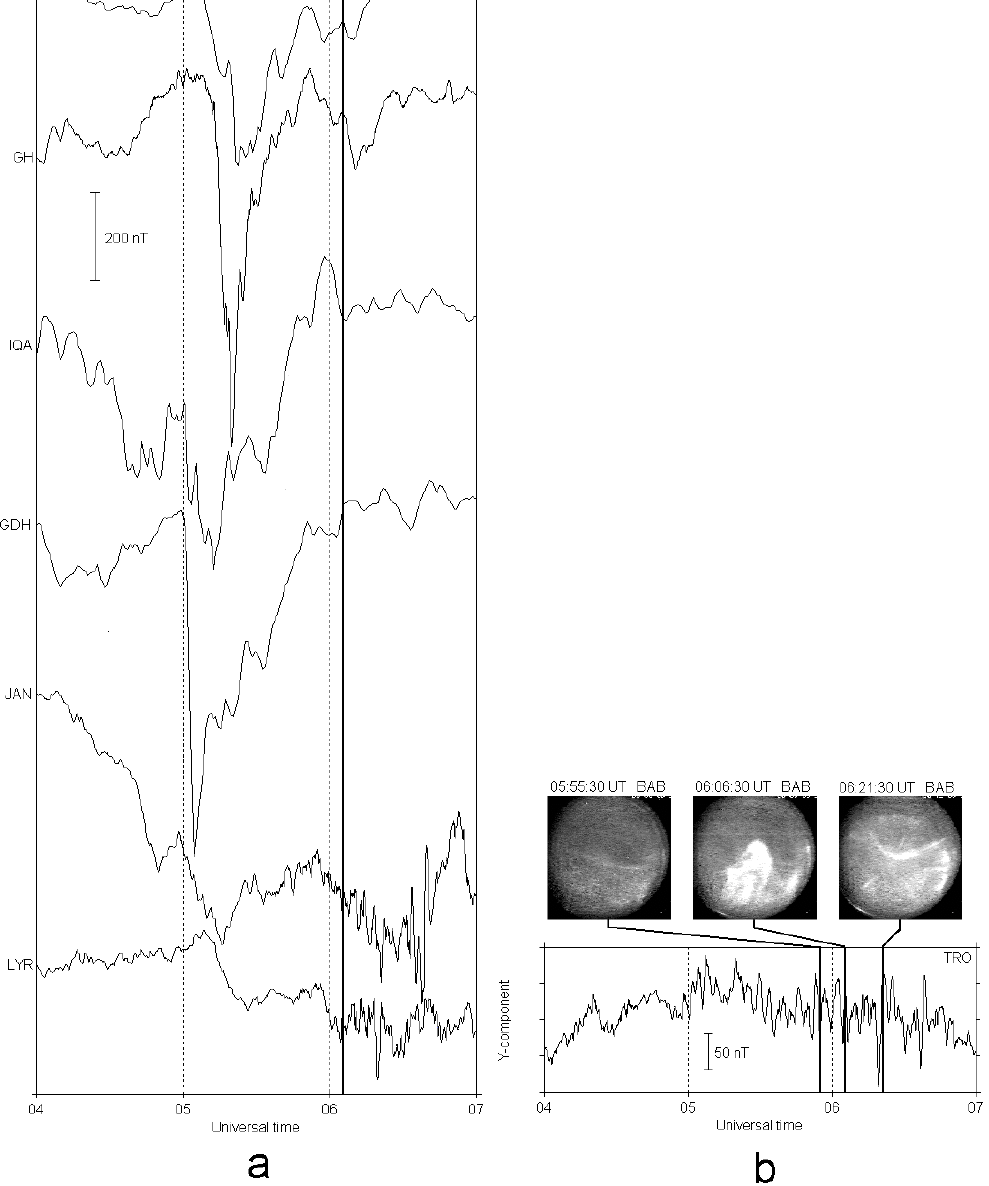
Fig. 3. (a) Substorm activity in the night side. Vertical bold line at 06:03 UT corresponds to the time of torch appearance. (b) Omega band-associated magnetic disturbances in the morning sector. The auroral torch (central image) and aurora activity before and after torch passage above BAB are also